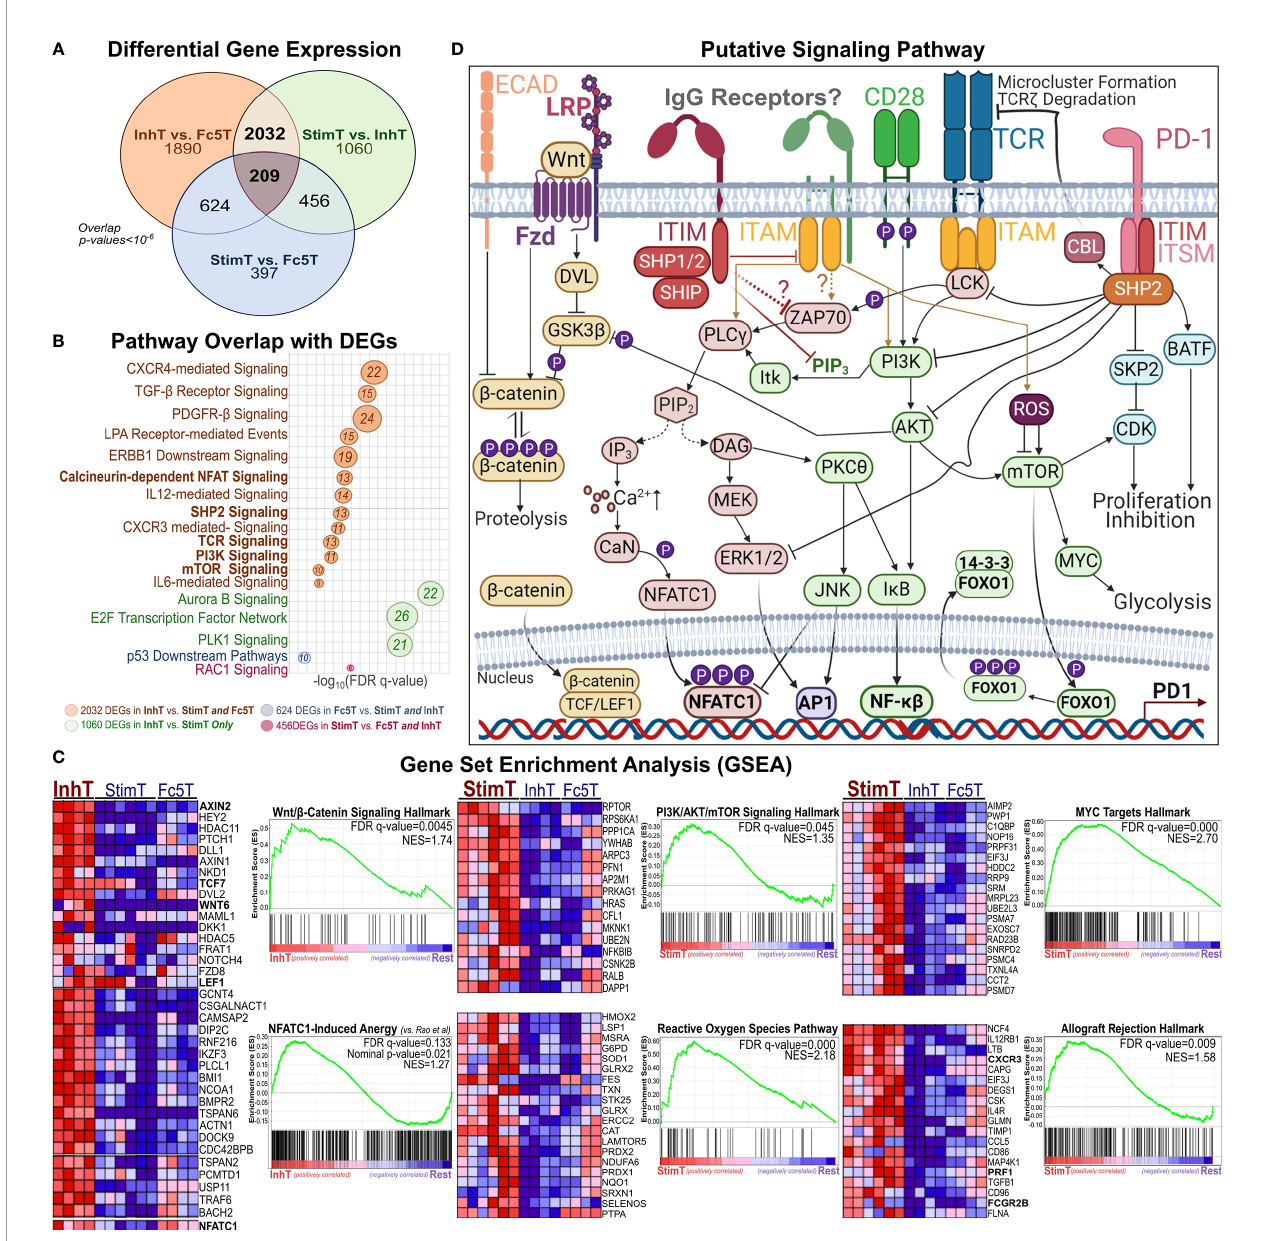
FIGURE 5 | Pathways Perturbed by IgG1 ICs Implicate SHP2, b -Catenin, and AKT/mTOR Signaling (A) Venn diagram showing the overlap of differentially expressed genes (DEGs) among StimT, InhT, and Fc5T. Genes are differentially expressed if the adjusted p-value < 0.05 and fold change ≥ 1.5 in either direction (B) bubble plot listing select pathways overlapping with observed DEGs. Bubble size is proportional to overlapping number of DEGs. x-axis represents -log(FDR-adjusted q-value) (C) Gene set enrichment analysis (GSEA); “ Rest ” represents any two of InhT, Fc5T, or StimT. For example, “ InhT vs. Rest ” compares InhT to both StimT and Fc5T. The y-axis shows the enrichment score (ES) for members of the gene set. The top portion of the plot shows the running ES for the gene set as the analysis walks down the ranked list of genes. The middle portion of the plot shows where the members of the gene set appear in the ranked list of genes. FDR q-value and the normalized enrichment score (NES) are shown. As recommended by GSEA for non-pre-ranked RNA- Seq, gene sets are considered signi fi cantly enriched if the FDR-q value < 0.25. Heatmaps represent select genes contributing to enrichment. By default, GSEA expression values are represented as a range of colors, where red, pink, light blue, and dark blue represent high, moderate, low, lowest expression, respectively. Other enriched pathways are shown in Table S6 (D) Putative signaling network hypothesizing how an IgG1 receptor may theoretically perturb other established T cell